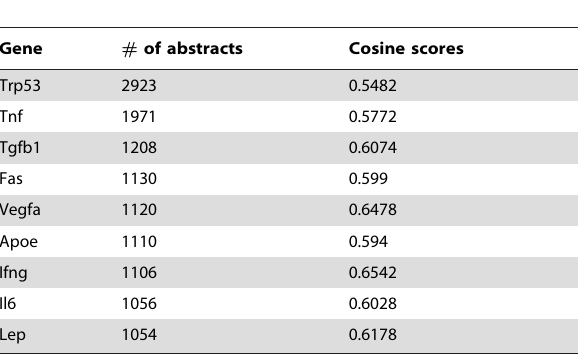
Figure 4. Relationships between abstract counts, LPv, and cosine scores. (A) The average number of abstracts for each gene set in GO was plotted against the 2 Log(LPv) for the group. (B) The top 10 cosine scores were averaged for each gene and plotted against the abstract count for the gene. doi:10.1371/journal.pone.0018851.g004 with a network graph, where genes are represented as nodes and the edges represent cosine values . 0.6. GCAT also provides the LSI similarity scores, which can be downloaded in tabular form, Table 3. Genes with greater than 1000 abstracts and the average cosine scores for their top 10 gene